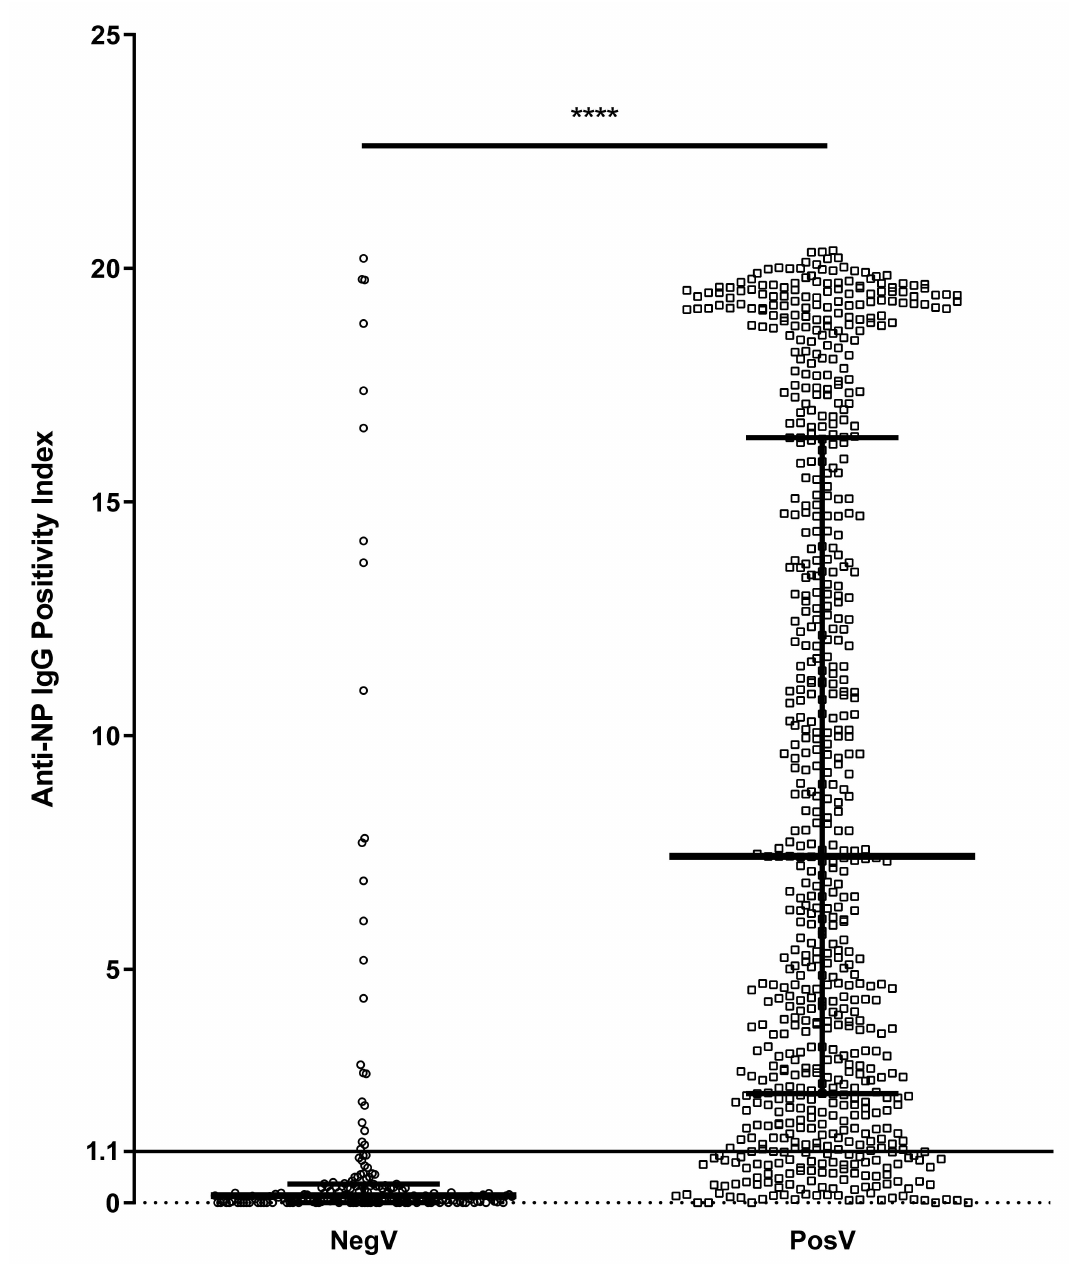
Figure 1. Distribution of positivity index (P.I.) of anti-NP IgG antibodies between negative/untested volunteers (NegV) ( n = 194) and SARS-CoV-2-positive volunteers (PosV) ( n = 695). The line at P.I. = 1.1 represents the threshold above which samples are considered positive. Bars represent median and interquartile ranges. **** p <